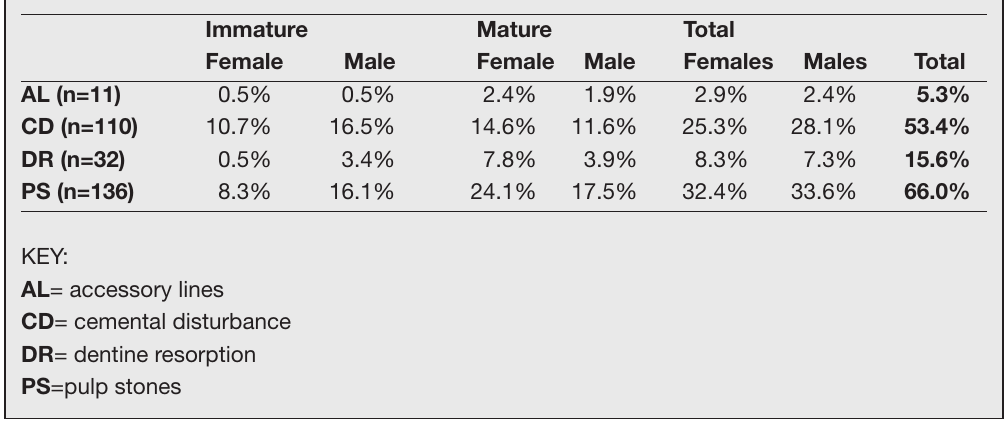
Table 2. The presence of anomalies recorded in 206 harbour seal